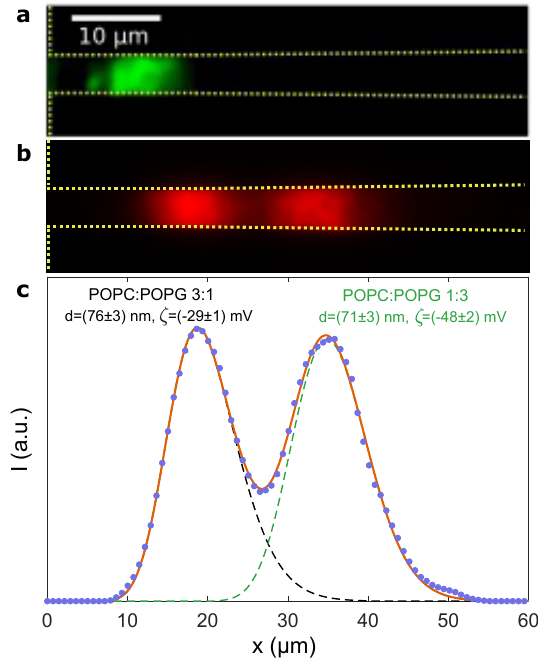
Fig 2. (a) Fluorescence image of a band of exosomes trapped in a nanochannel by a salinity gradient. From the analysis we obtain an exosome diameter of (78±7) nm and a zeta potential of (-18±1) mV. (b) Fluorescence image of trapped liposomes from a mixture. Two bands appear due to the different zeta potential of the two subpopulations. (c) Fluorescence intensity of the liposomes shown in panel c and a corresponding fit. The values of the fitted parameters are shown on the figure.